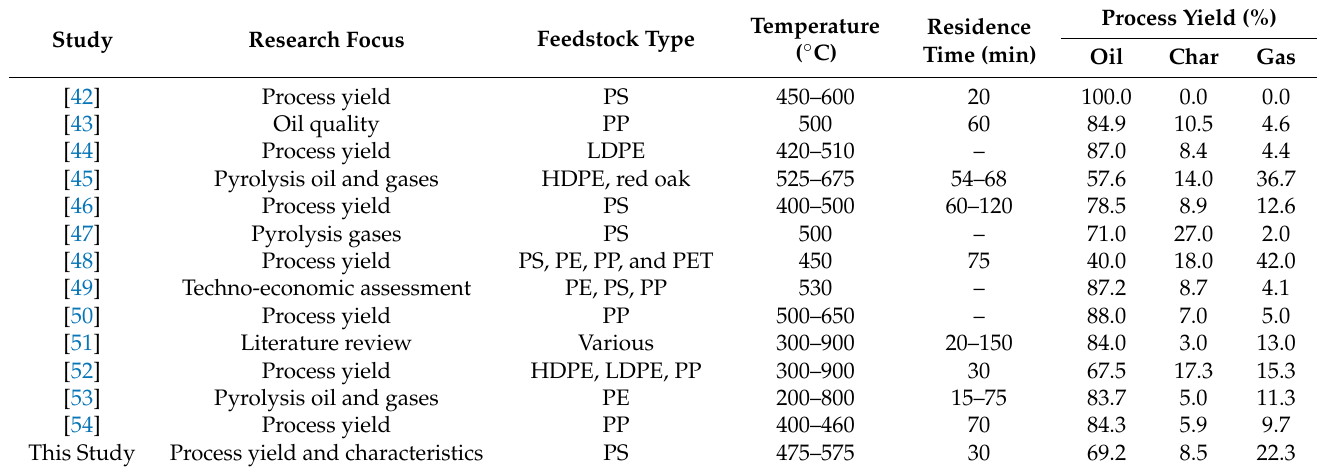
Table 6. Recent studies on plastic waste recycling via the pyrolysis